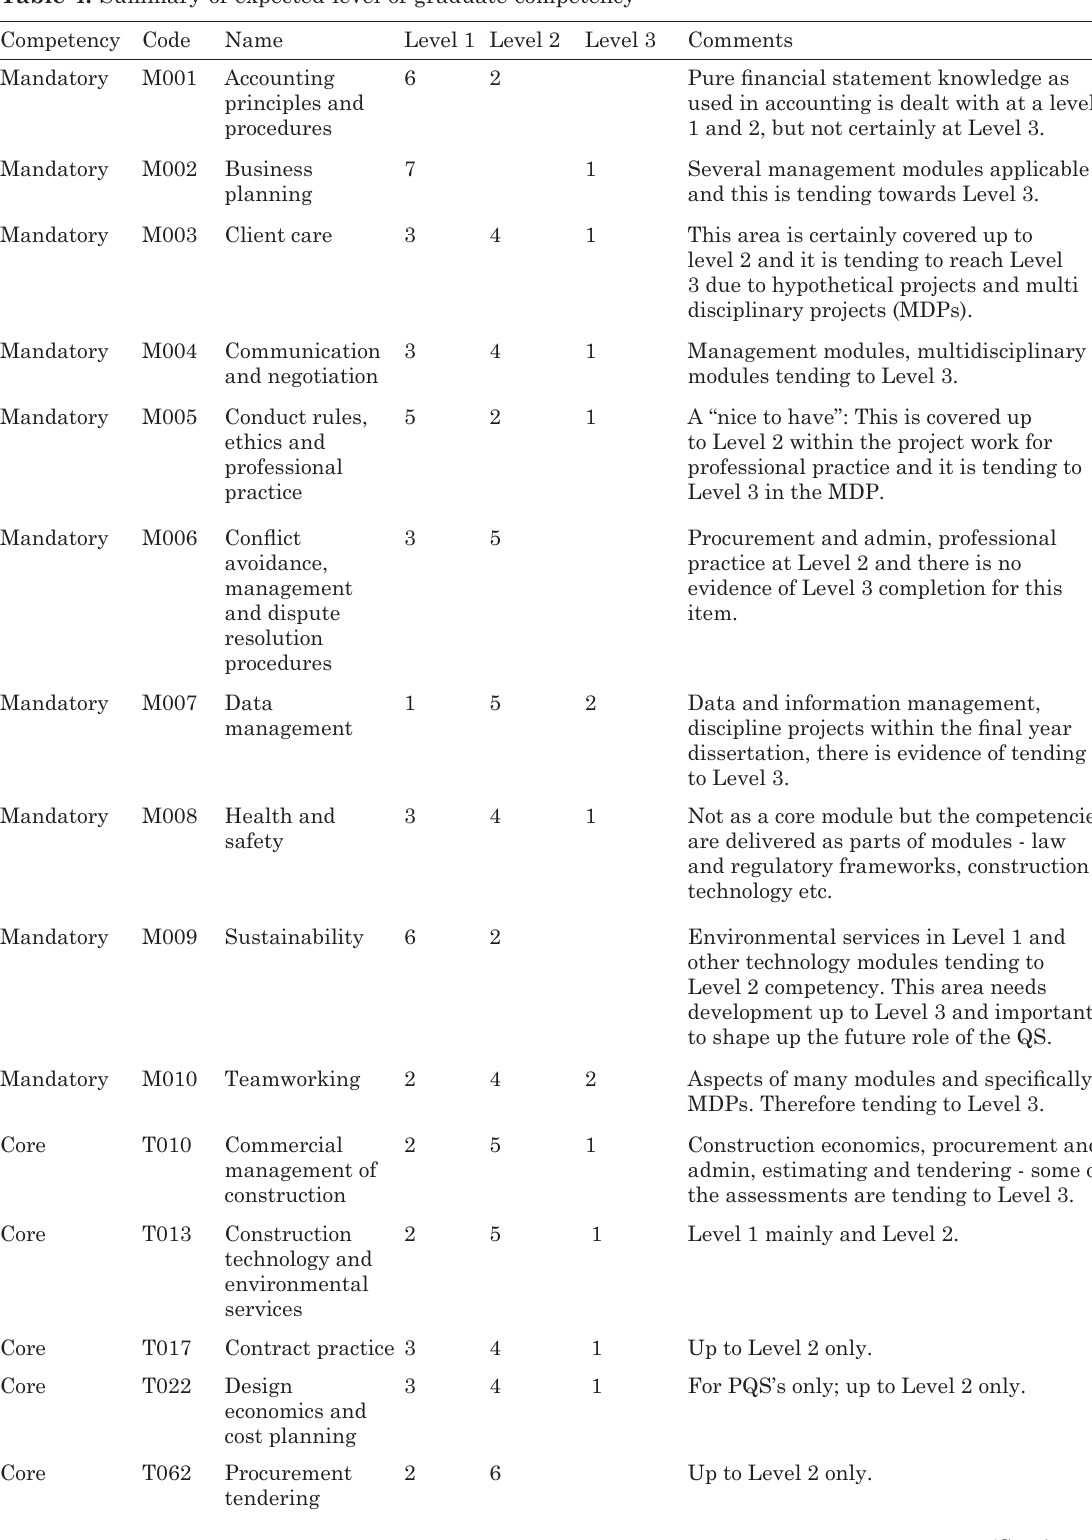
Table 4. Summary of expected level of graduate competency Competency